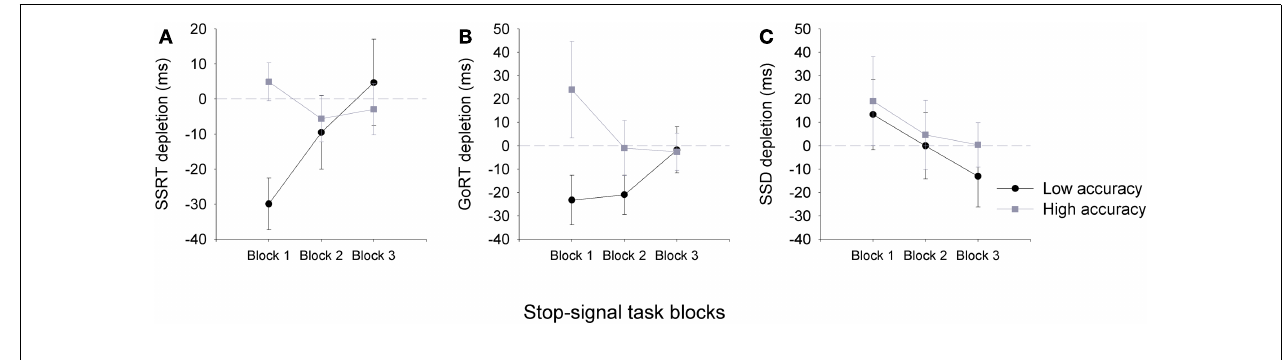
FIGURE 2 | Mean ( ± SEM) depletion measures for SSRT (A), go-RT (B), and SSD for the low accuracy (black line) and high accuracy (gray line) (C) groups across the three blocks of the stop-signal task: Block 1 (0–5min), Block 2 (5–10min), and Block 3 (10–15min). Depletion measures were calculated by subtracting SST task measures following the arithmetic task from those that